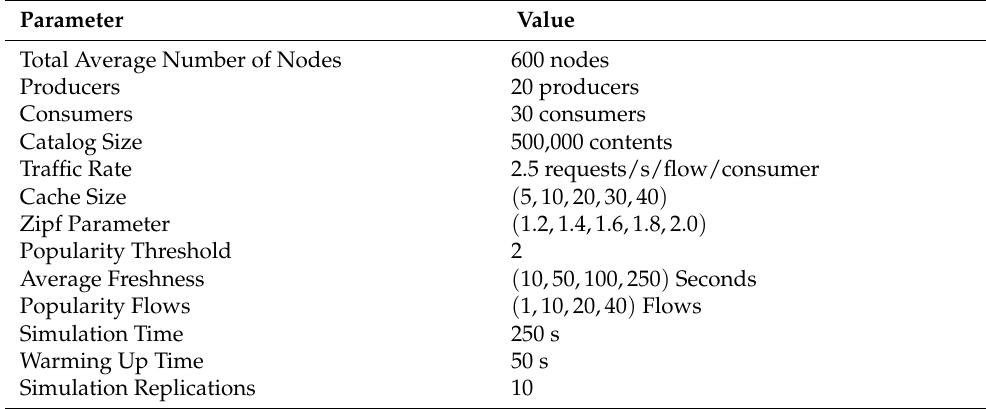
Table 1. Simulation